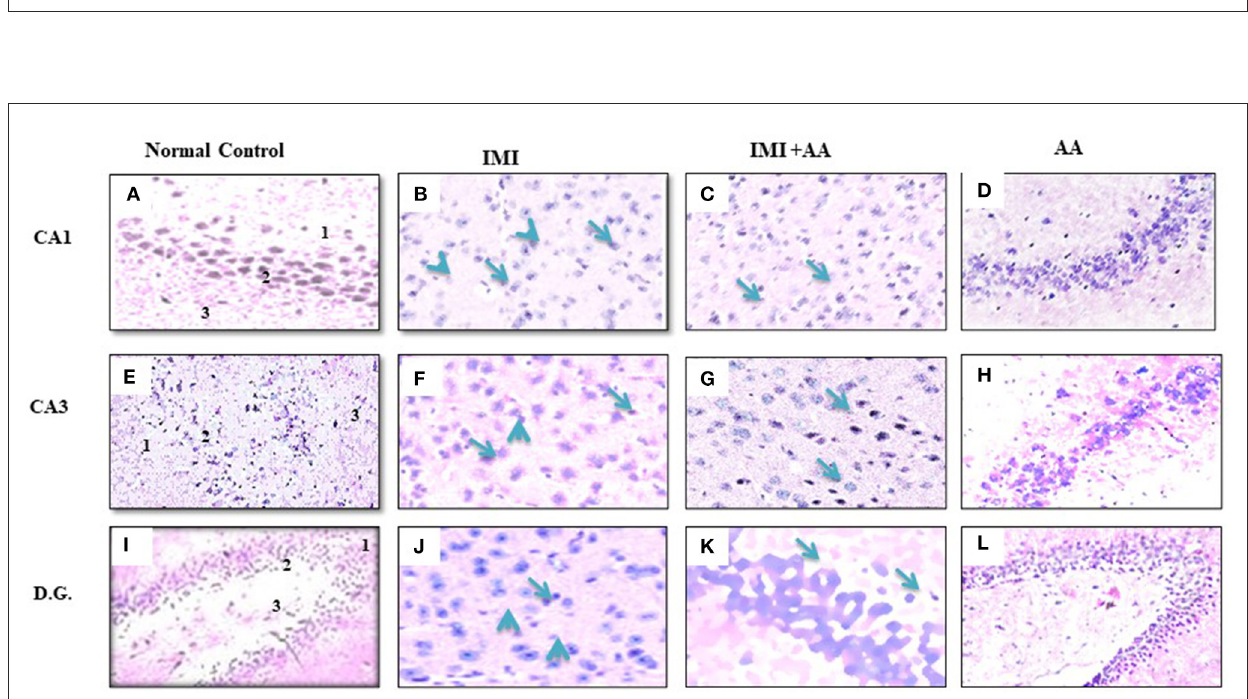
FIGURE2 Histopathological assessments of the brain hippocampus areas. (A, E) CA1 and CA3 hippocampal regions control mice indicates normal morphology of hippocampus layers (superficial polymorphic layer “1,” middle pyramidal cells layer “2,” and inner molecular layer “3”) with regularly arranged intact neurons. (B, F) CA1 and CA3 hippocampal areas of IMI treated mice indicates severe disarrangement of pyramidal cell layers, many apoptotic cells with dark blue stained nuclei and apparent a high number of glial cells (arrowheads). (C, G) CA1 and CA3 hippocampus regions of IMI + Ascorbic acid treated mice respectively show more organized pyramidal cells, apparent intact neurons (arrow) scattered among damaged shrunken neurons with pyknotic nuclei (arrow), and mild glial cells infiltration. (D, H) CA1 and (CA3) regions of Ascorbic acid treated mice represents normal and healthy cells at hippocampal layer with regular intact neurons. (I) Dentate Gyms hippocampal region of control mice demonstrated normal morphological architecture (molecular layer “1,” granular layer “2,” and hilum “3”) with well-organized neurons bearing intact nuclei. (J) Dentate Gyrus of IMI treated mice shows disorganized granular layer with severe edema (arrow), many apoptotic cells (dotted arrow), shrinking hilar cells (arrowhead), and increased number of glial cells. (K) Dentate Gyms of IMI + Ascorbic acid treated mice shows more organized hippocampal zones with moderate edema (arrow), many apoptotic cells (dotted arrows), and many glial cells are still evident. (L) Dentate Gyms of Ascorbic acid treated mice shows organized hippocampal zones (400 ×